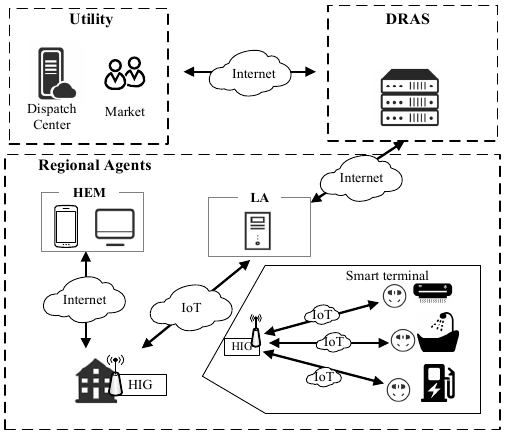
Figure 1. The framework of the multi-communication demand response (DR) system.